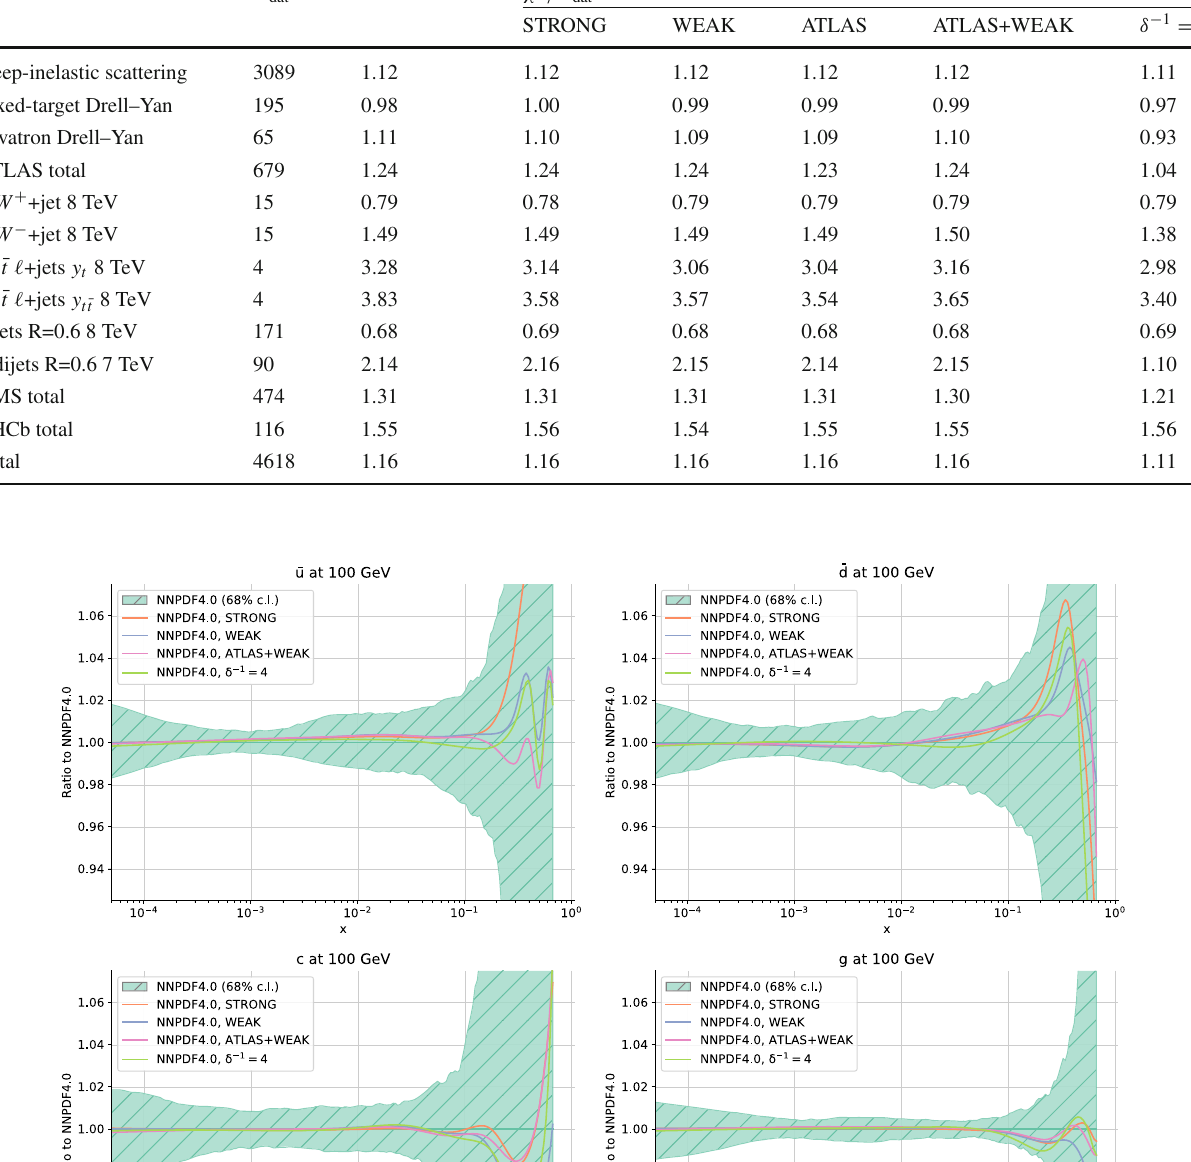
malised to its central value. Also shown are the PDFs obtained in a fit to the NNPDF4.0 data set regularised with δ − 1 = 4. For all PDFs but the NNPDF4.0 baseline, we show only the central value. Otherwise the uncertainty corresponds to the 68% confidence interval. All PDFs are accurate to